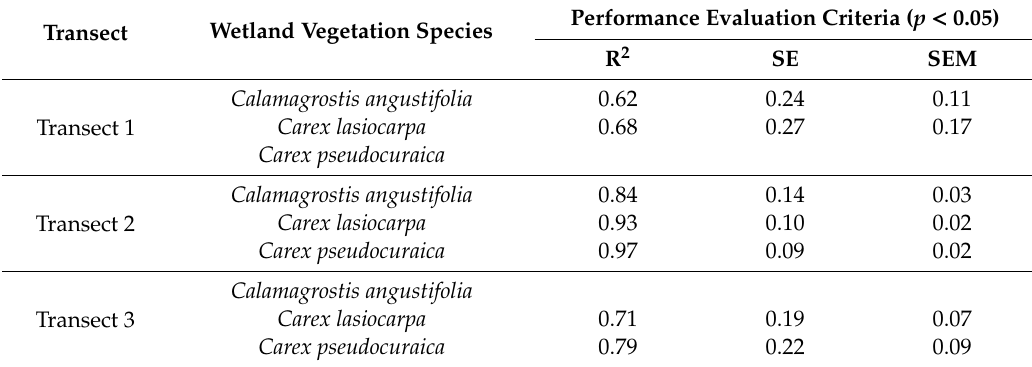
Table 2. Statistical comparison of the observed and simulated vegetation distribution probability in